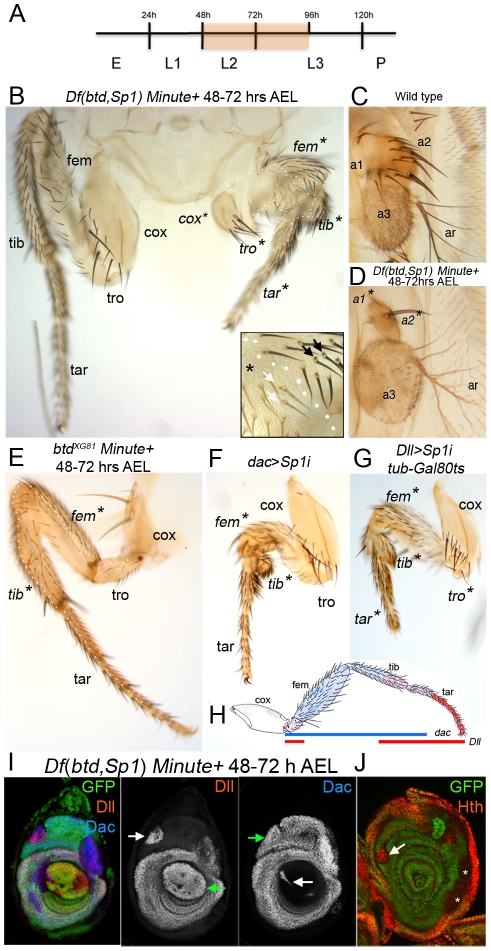

btd and Sp1 control leg growth.(A) Time line showing when removing the function of btd and Sp1 affects leg growth (orange shadow). (B) A large Df(btd,Sp1) M+ clone in a T1 leg induced 48–72 hrs AEL and marked by yellow (y) bristles (the clone boundary is indicated by the white dotted line in the left leg). For comparison, the wild type right T1 leg is included in this image. The mutant tissue still maintains leg identity scored by the presence of bracted bristles (arrows, inset). Asterisks mark the segments affected by the clone. The same leg segment nomenclature has been used for all the figures: coxa (cox), trochanter (tro), femur (fem), tibia (tib) and tarsus (tar). (C) Wild type antenna with 1st antennal segment (a1), 2nd antennal segment (a2), 3rd antennal segment (a3) and arista (ar). (D) Df(btd,Sp1) M+ clone induced 48–72 hrs AEL results a strong reduction in size of the a1 and a2 antennal segments, while a3 and the ar are normal. The clone is marked by y. (E) A large btdXG81 M+ clone in a T2 leg induced 48–72 hrs AEL and marked by y (clone is outlined by white dots) results in a small growth defect in the femur (fe) and tibia (tib), which are also partially fused (arrow). The tarsus (tar), trochanter (tro) and coxa (cox) are unaffected. (F, G, H) The downregulation of Sp1 beginning at the second instar using RNAi affects the growth of the entire leg. Two different Gal4 drivers were used to examine different regions of the leg. (F) The medial part of the leg is strongly reduced in size in dac-Gal4; UAS-Sp1i flies. (G) The distal part of the leg is strongly reduced in size in Dll-Gal4; UAS-Sp1i flies. In this experiment we blocked Gal4 activity prior to the second instar using tub-Gal80ts. (H) Shows a schematic representation of the expression patterns of the two Gal4 drivers used to downregulate Sp1 function (dac in blue and Dll in red). (I, J) Df(btd,Sp1) M+ clones induced 48–72 hrs AEL and examined in 3rd instar leg discs. (I) A subset of Df(btd,Sp1) M+ clones (marked by the absence of GFP) show de-repression of Dll in the Dac domain and de-repression of dac in the Dll domain (white arrows). Note that these clones do not affect the expression of Dll and dac in their normal expression domains (green arrows). (J) A subset of Df(btd,Sp1) M+ clones (marked by the absence of GFP) show derepression of hth (arrow). Clones that do not derepress hth are indicated with asterisks.